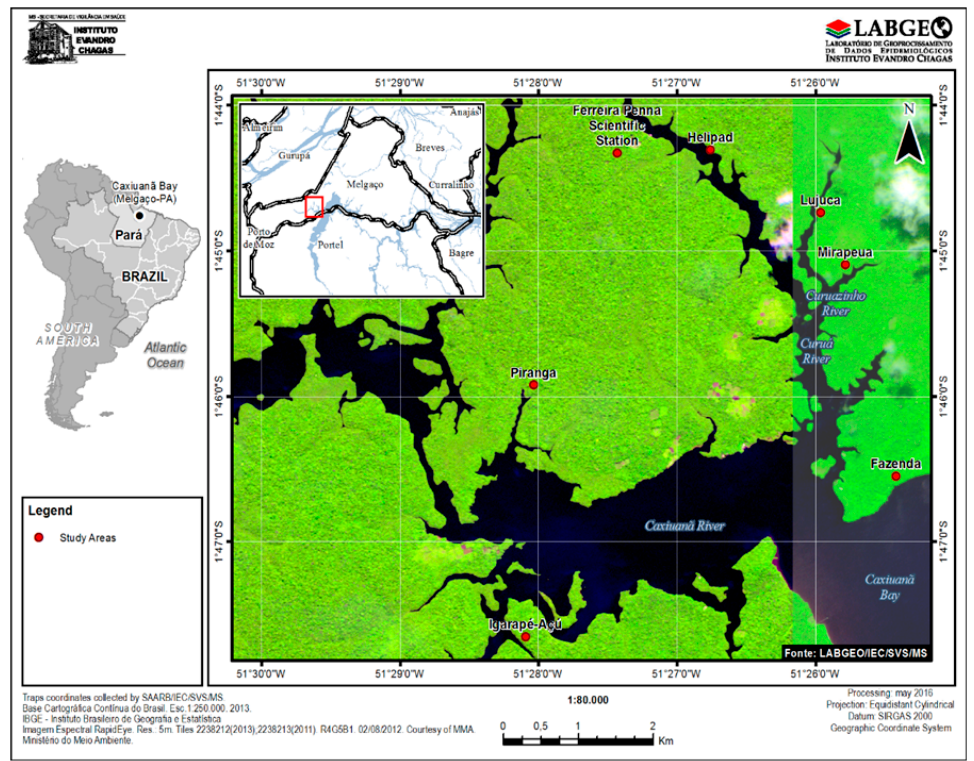
Figure 1. Cartographic representation of study areas at FLONA de Caxiuanã. Source: IEC . Green area: the continent; Blue area: the river.